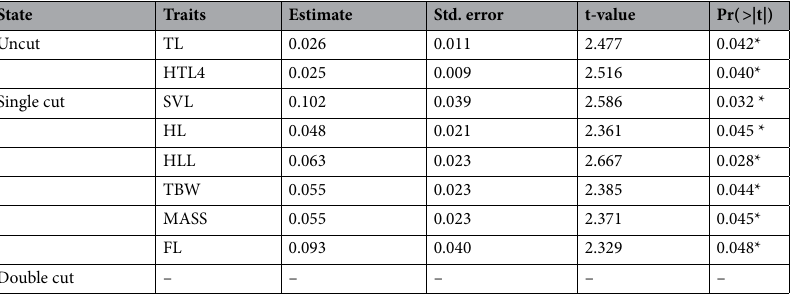
Table 2. Effect of morphology on the maximum acceleration under three states estimated using PLS. Estimate represents the regression coefficients for the traits on speed. The standard error of the estimate (Std. error), t values and probabilities (Pr( >|t|)) were estimated using the jack knife procedure in the pls package of R. Significance levels: * P < 0.05, ** P < 0.01.